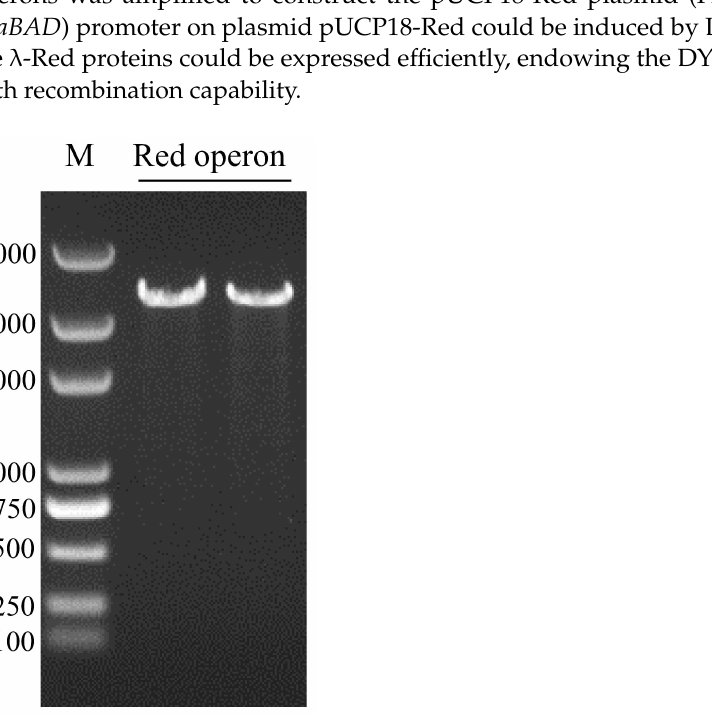
Figure 8. Verification of the Red operon fragment by PCR. M: DL5000 DNA Marker. Red operon indicates the amplified Red operon fragment from pKD46 plasmid with RedF and RedR primers. After electroporating, digestion of the recombinant plasmid extracted from the DY- 1/pUCP18-Red colony was carried out with Hind III, generated an expected band of around 7.9 kb (Figure 9, Lanes 1–4). After then, the fragment consisted of the upstream region, kanR , and downstream region was obtained, purified, and electroporated into DY-1/pUCP18- Red. The mo5660 gene was then deleted by the integration of kanR , which was confirmed with PCR with the non-mutant DY-1/pUCP18-Red (wild type) as the control.